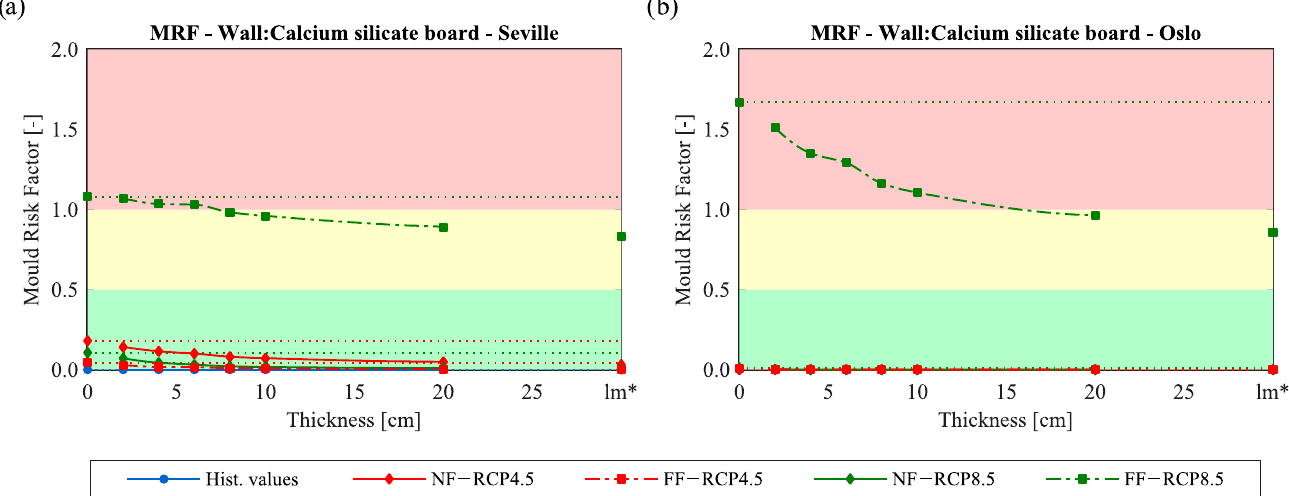
Figure 4. Biological decay assessment (MRF) for the case study with calcium silicate board for Seville ( a ) and Oslo ( b ). This figure shows the results for historical, near-future, and far-future time frames for the case study with a wall retrofit measure and for the case without retrofits (dotted lines). lm* is an additional “virtual” thickness that corresponds to a 30 cm layer